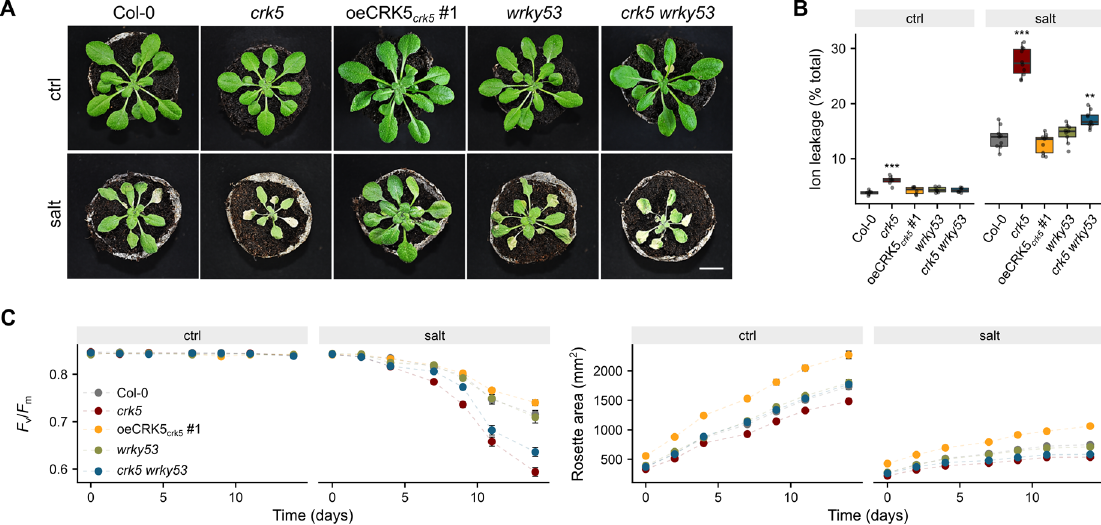
Figure 7. ( A ) Morphological phenotype of plants treated with 450 mM NaCl for 14 days. ( B ) Relative cellular electrolyte leakage was measured after 14 days of salt treatment compared to non-treated plants. Dots represent individual observations. Mean values ( ± SD) are derived from 10 plants ( n = 10). Asterisks indicate a significant difference relative to Col-0 according to the one-way ANOVA and Tukey HSD test at level p < 0.001 (***), p < 0.01 (**). ( C ) The dynamics of maximum quantum yield of photosystem II ( Fv/Fm ) and plant growth within the osmotic stress treatment. Data represent mean values of 10 plants ( n = 10). The statistics for Figure 7C ( p -values of Tukey HSD test compared to Col-0) were presented in Table S4 in the supplementary